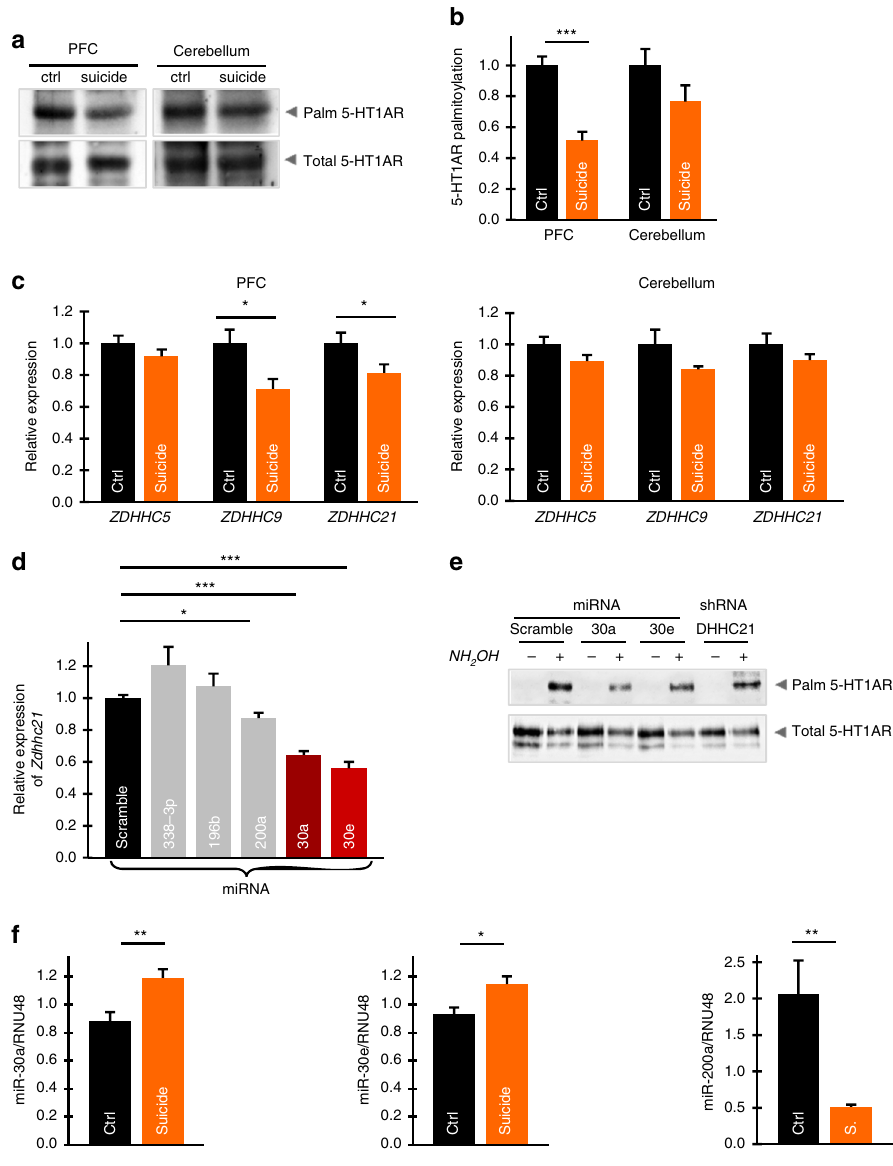
Fig. 6 Attenuated 5-HT1AR palmitoylation in the prefrontal cortex (PFC) of individuals with major depressive disorder (MDD) who died by suicide correlates with reduced expression of ZDHHC21. a 5-HT1AR palmitoylation in the PFC and cerebellum from the control and individuals with MDD who died by suicide (PFC, n = 5; cerebellum, n = 4). b Normalized level of 5-HT1AR palmitoylation in the PFC and cerebellum of individuals with MDD who died by suicide in comparison with control subjects (two-tailed t test; see also Supplementary Fig. 8). c Relative expression levels of ZDHHC5, -9, and -21 in the PFC (left) and cerebellum (right) of control ( n ≥ 14) and individuals with MDD who died by suicide ( n ≥ 12). Data points represent the means ± SEM (* P < 0.05; *** P < 0.001; two-tailed t test). d N1E cells were transfected with microRNAs as indicated and the expression of ZDHHC21 was determined by reverse transcriptase-PCR (see also Supplementary Table 1). Data points represent mean ± SEM from at least three independent experiments (* P < 0.05; *** P < 0.001; two-tailed t test). e N1E cells were transfected with 5-HT1AR along with miR-30e, miR30-a, or shRNA against ZDHHC21. Palmitoylation of 5- HT1AR was analyzed by acyl-biotinyl exchange. Western blots shown are representative of at least three independent experiments. f Analysis of miR-30a, -30e, and -200a expression in the PFC of control and individuals with MDD who died by suicide. (* P < 0.05, ** P < 0.01; two-tailed t test). Source data